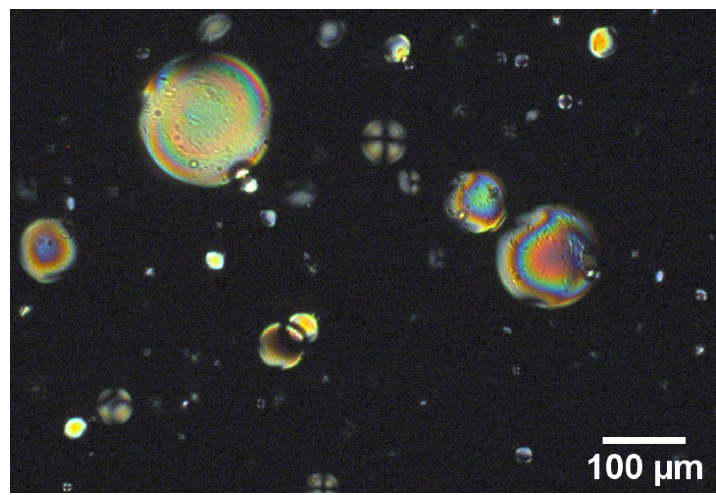
Figure 3. Pure DSCG confined in microspheres and observed by POM.